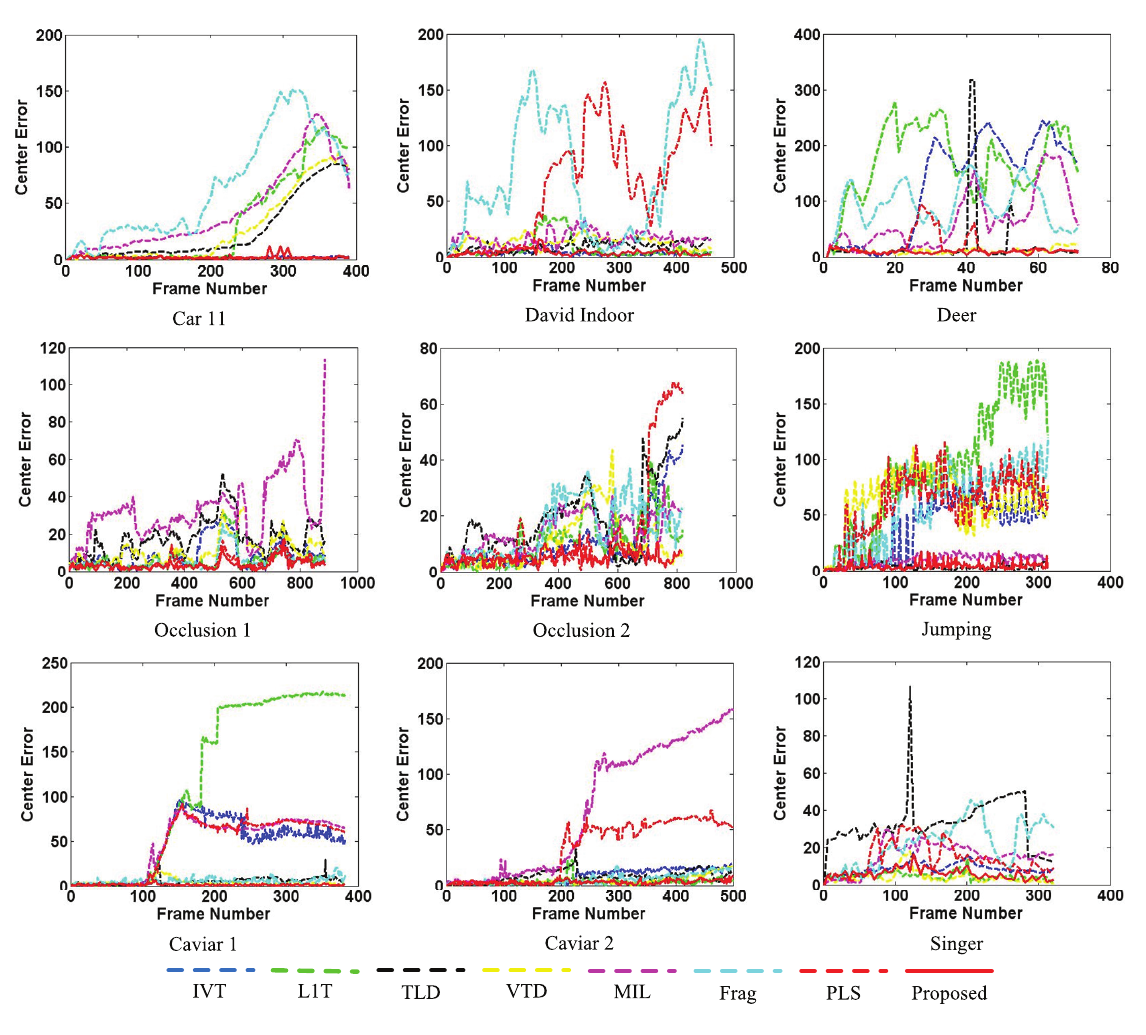
Figure 9. Center error (CE) evaluation for nine video clips. The proposed algorithm is compared with seven state-of-the-art methods: Frag[4], IVT [3], VTD [16], L1T [11] , MIL [9], TLD [10] and PLS